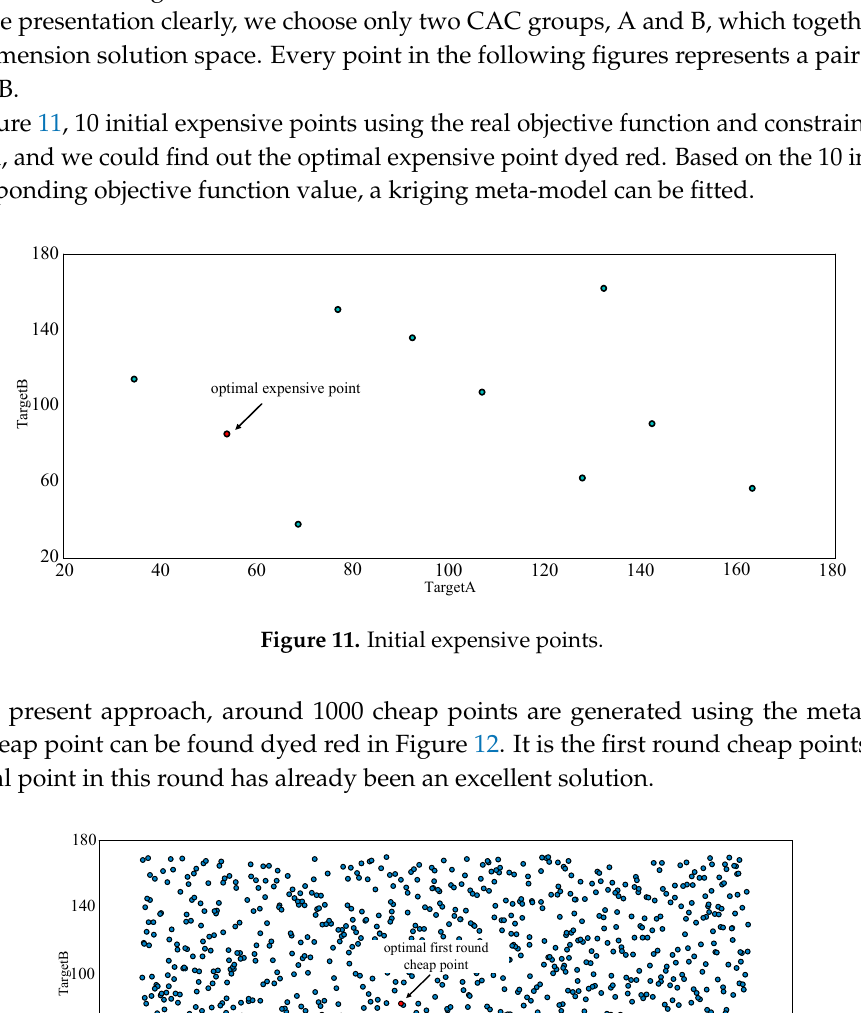
Table 1. Basic Simulation Parameters.